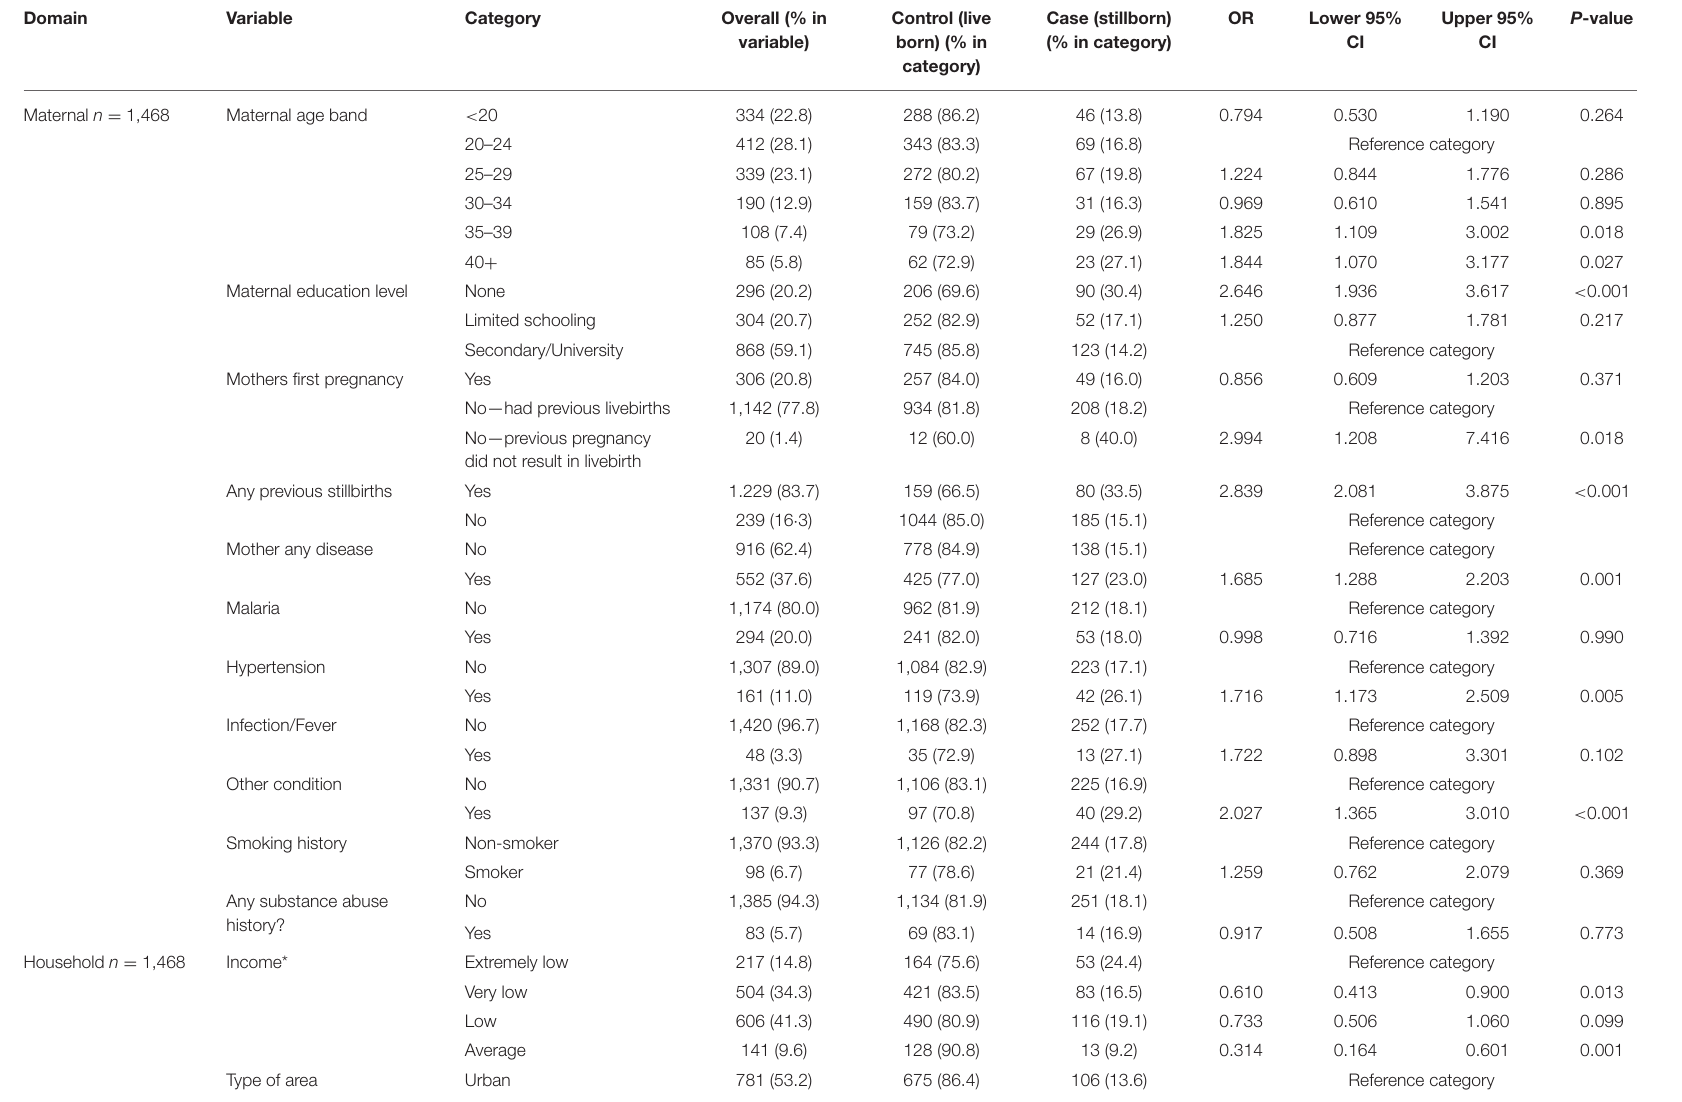
TABLE 2 | Univariable results from S2: Cohort study. Detailing demographic characteristics of the study participants, the distribution variables within each of the domains, and the extent to which each variable is associated with stillbirth. Domain